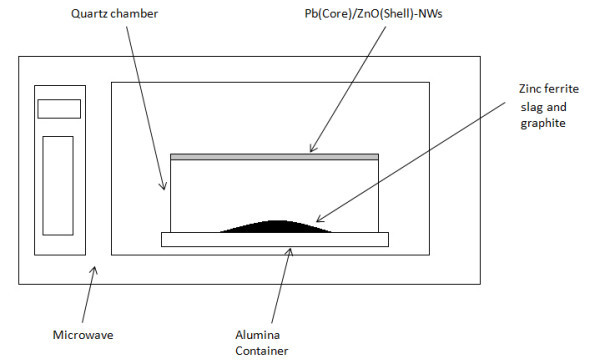
Experimental setup.